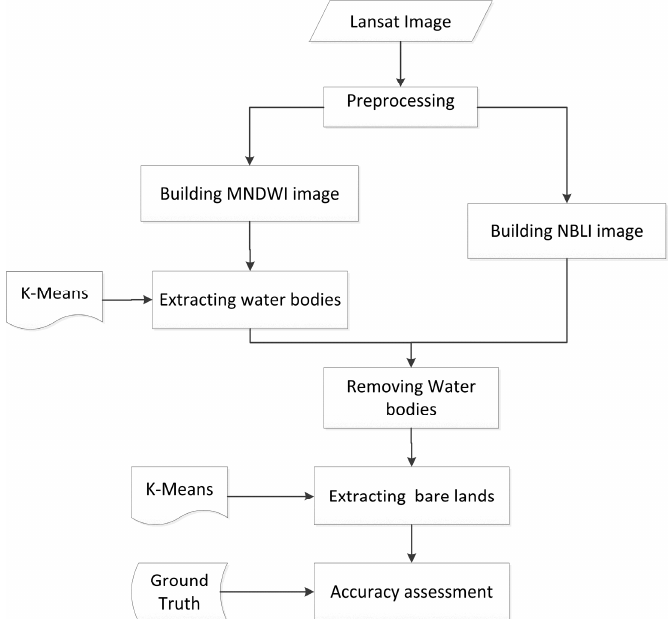
Figure 5. The flowchart of the automatic mapping method.